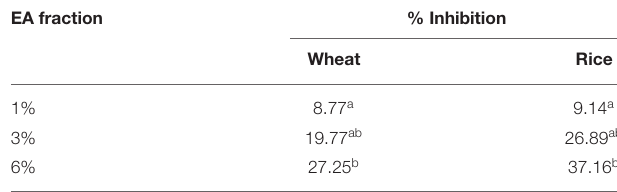
TABLE 1 | Percentage inhibition of wheat and rice noodles